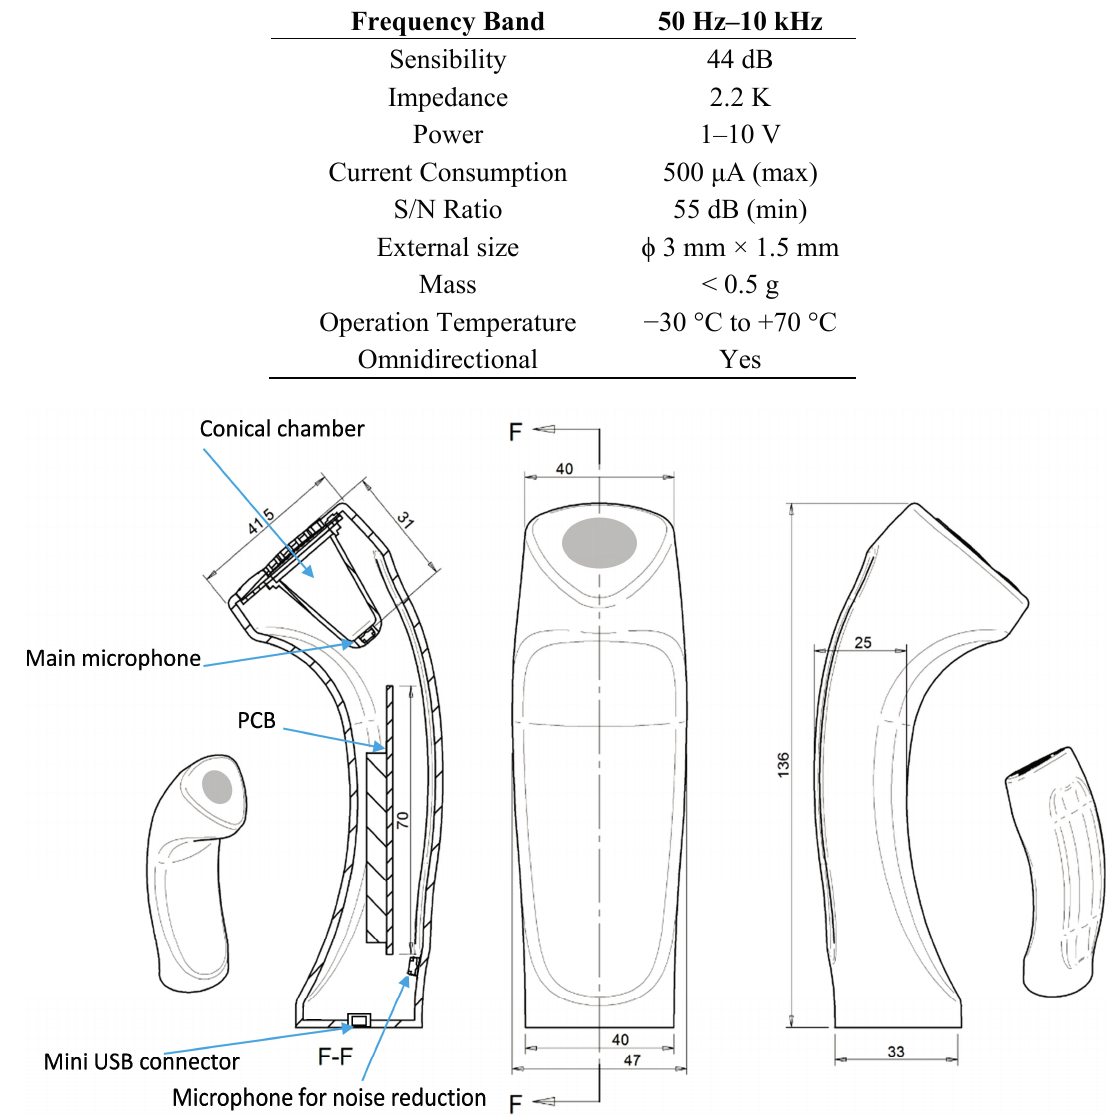
Figure 1. Remote respiratory sensor device. The mini USB connector, the printed circuit board (PCB) with the digitising hardware, the main microphone, the air-coupled conical chamber and the microphone for environmental noise reduction are